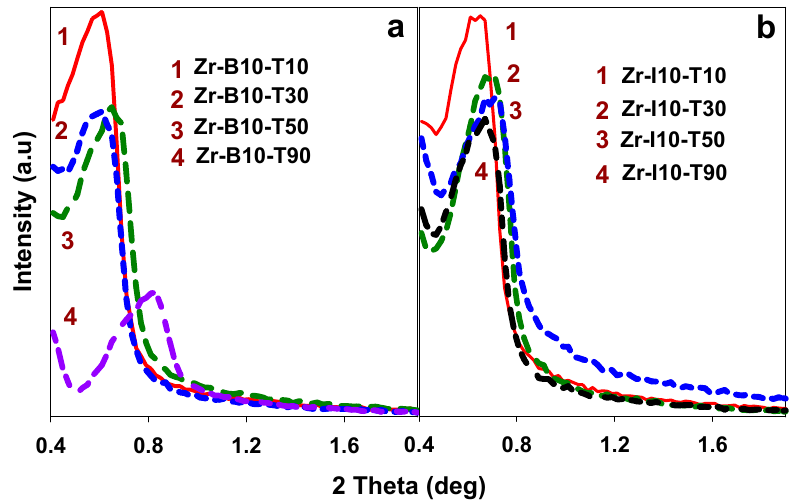
Figure 7. Small-angle XRD patterns for ( a ) Zr-B10-TX and ( b ) Zr-I10-TX samples. Figure 7. Small ‐ angle XRD patterns for ( a ) Zr ‐ B10 ‐ TX and ( b ) Zr ‐ I10 ‐ TX samples. Wide-angle-powder-X-ray-diffraction measurements were conducted to study the crys- talline properties of the selected Zr-I10-T50, Zr-B10-T50, and Zr # samples (see Figure S6a). Wide ‐ angle ‐ powder ‐ X ‐ ray ‐ diffraction measurements were conducted to study the Figure S6a, Supplementary Information, shows the XRD patterns of the Zr # and Zr-I10-T50 crystalline properties of the selected Zr ‐ I10 ‐ T50, Zr ‐ B10 ‐ T50, and Zr # samples (see Figure samples. The pattern for the Zr # sample shows four XRD peaks at 2 θ , equal to 31.12 ◦ , 45.69 ◦ , 56.40 ◦ , and 75.38 ◦ , with d-spacings of 2.87 Å, 1.98 Å, 1.63 Å, and 1.26 Å, respectively. All peaks correlate with NaCl-structural patterns (note that only a small amount of